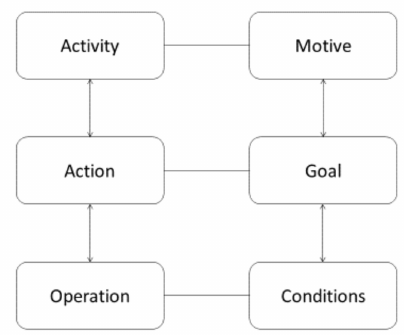
Figure 1. Activity levels (modified from